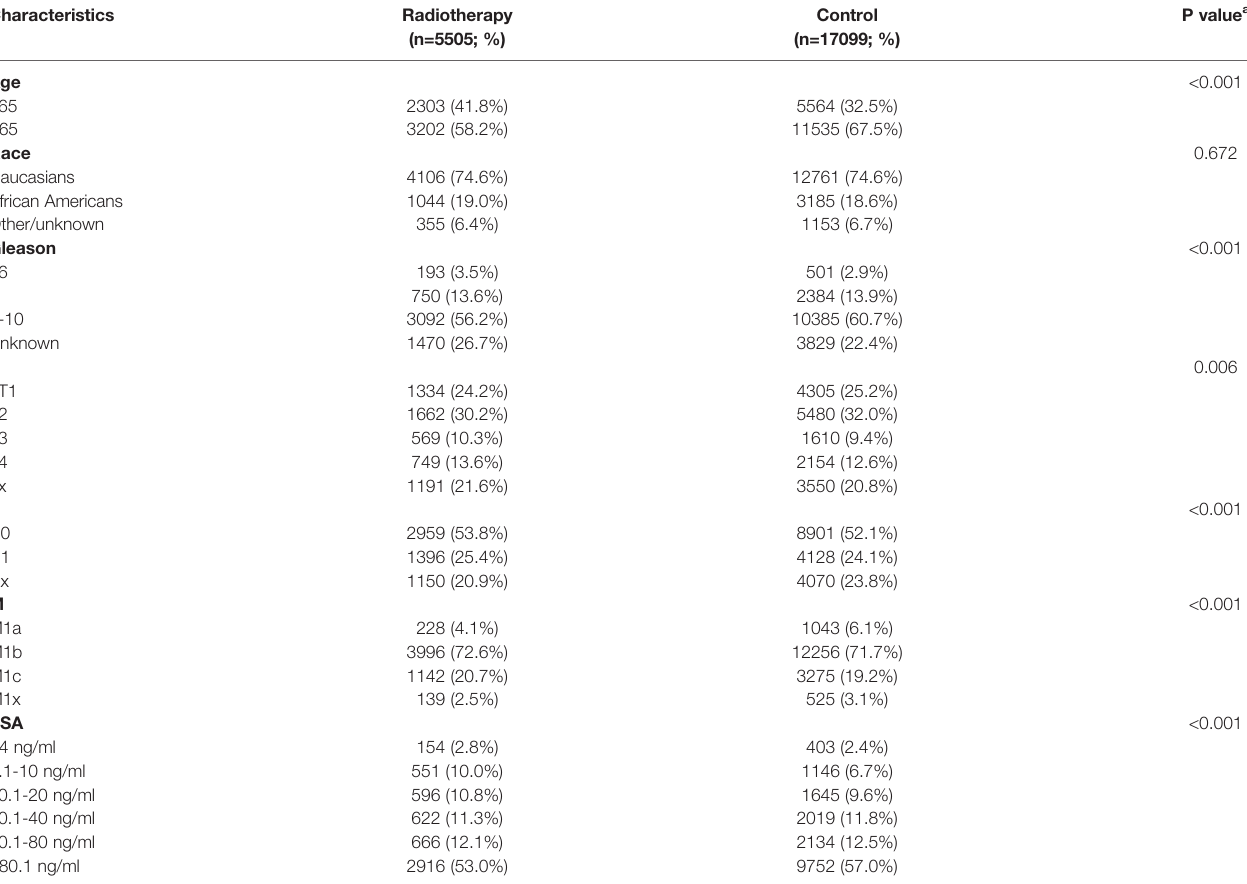
TABLE 1 | Clinicopathological characteristics of the cohort by treatment groups.